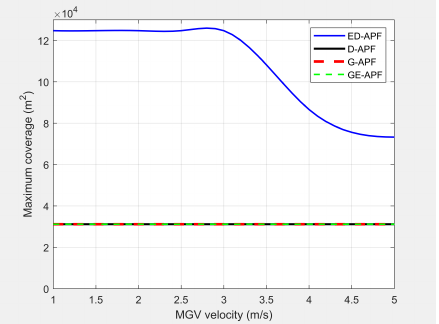
Figure 28. Comparison of the maximum coverage for different velocities of the